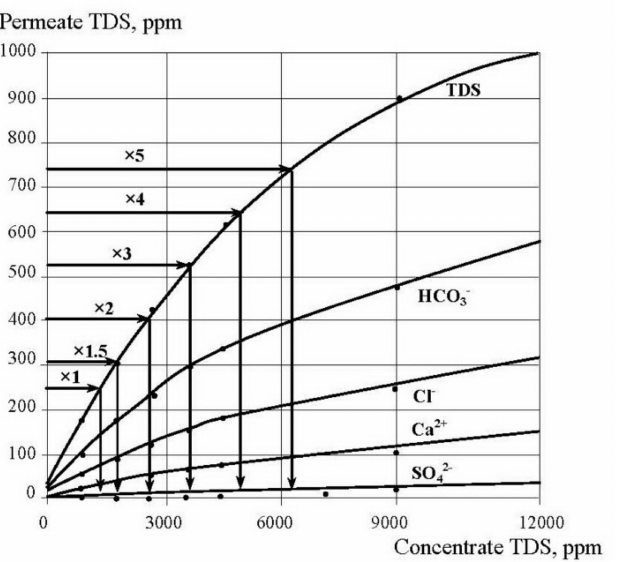
Figure 7. Dependencies of concentrate TDS and other species concentrations on K.